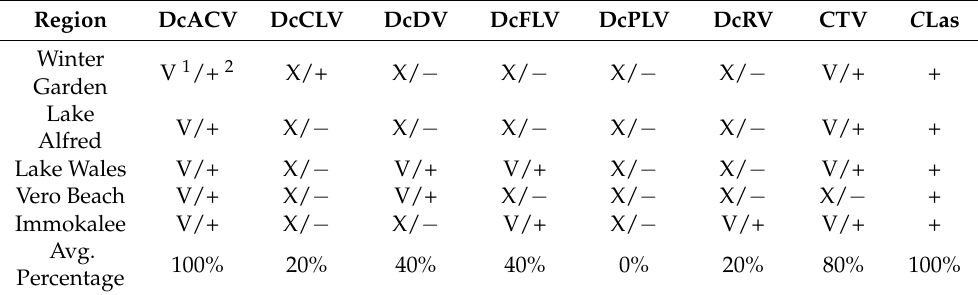
Table 4. The Florida regional presence of D. citri − associated viruses, Citrus tristeza virus (CTV) and Candidatus Liberibacter asiaticus ( C Las) in composite psyllid gut samples.